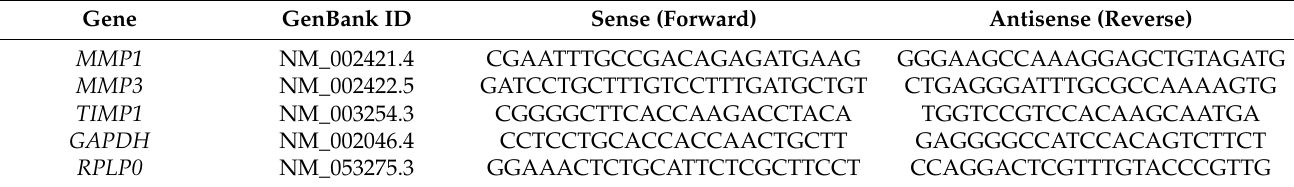
Table 2. Primer sequences for RT–qPCR analyses of treated NHEKs and